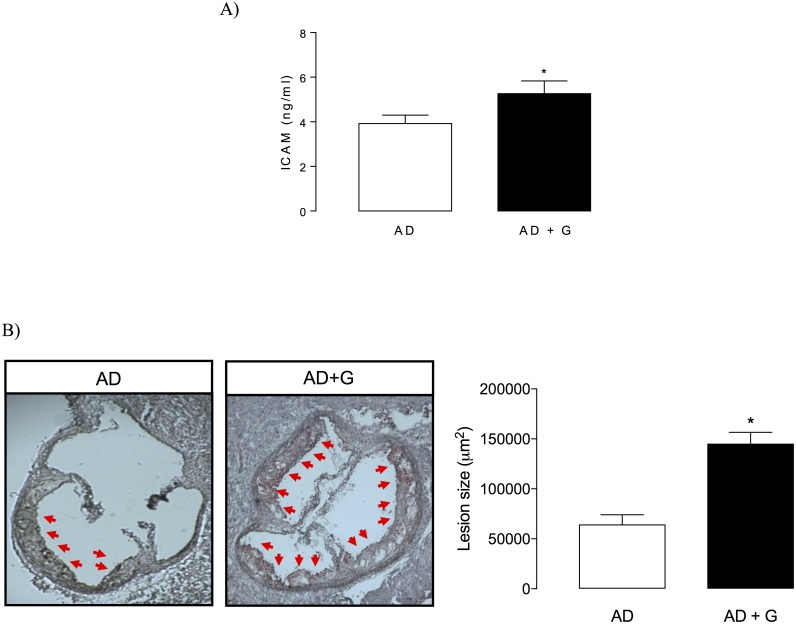
Effect of gugulipid on plasma intercellular adhesion molecule (ICAM) levels and atherosclerosis in atherogenic diet fed male apoE KO mice.(A) Plasma ICAM levels and (B) neutral lipid staining (left) and quantitation (right) of atheromatous lesion size in aortic roots of control and gugulipid-treated atherogenic diet-fed mice. Arrows indicate atheromatous lesions. AD: atherogenic diet; G: gugulipid. Two independent experimental sets were used, n = 6 in each. Values represent mean ± SD. *P<0.05.